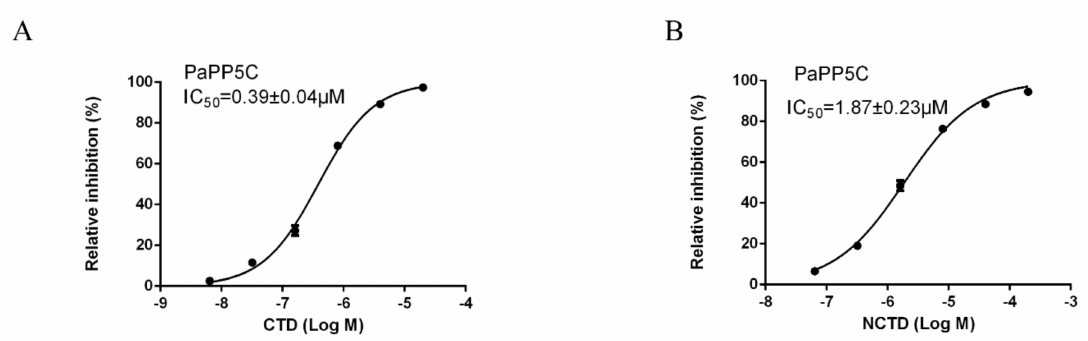
Figure 5. Inhibition curves of Cantharidin and Norcantharidin on the catalytic domain of PP5 (PP5c). Data are shown as mean ± SD. ( A ) Cantharidin, ( B )